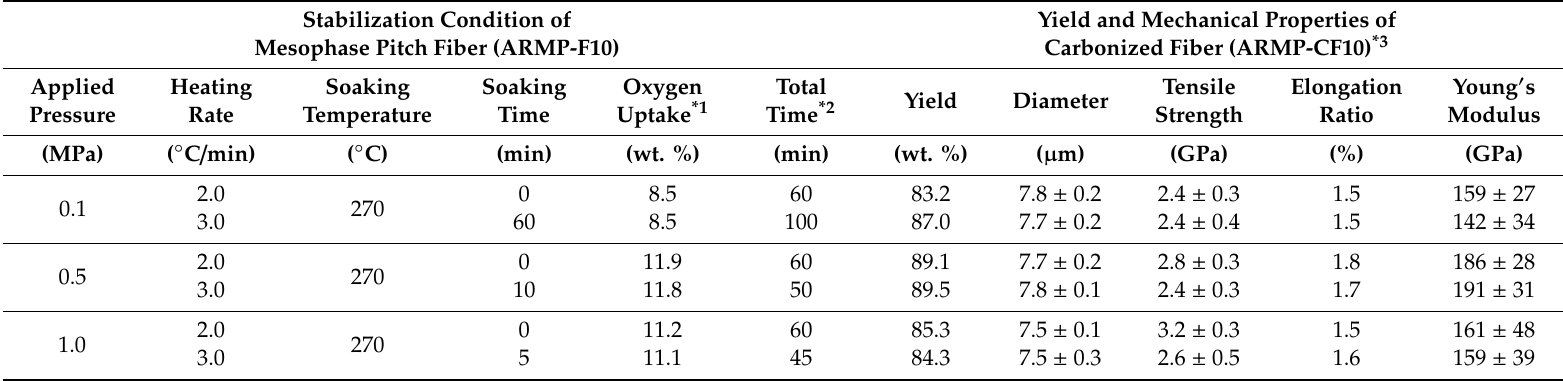
Table 2. The results of the stabilization under atmospheric and pressurized conditions using laboratory stabilization apparatus, yields, and mechanical properties of carbonized fibers (heating rate of stabilization: 2.0 and 3.0 ◦ C / min, soaking time: 0–60 min). ARMP-CF, AR mesophase pitch carbonized fiber.